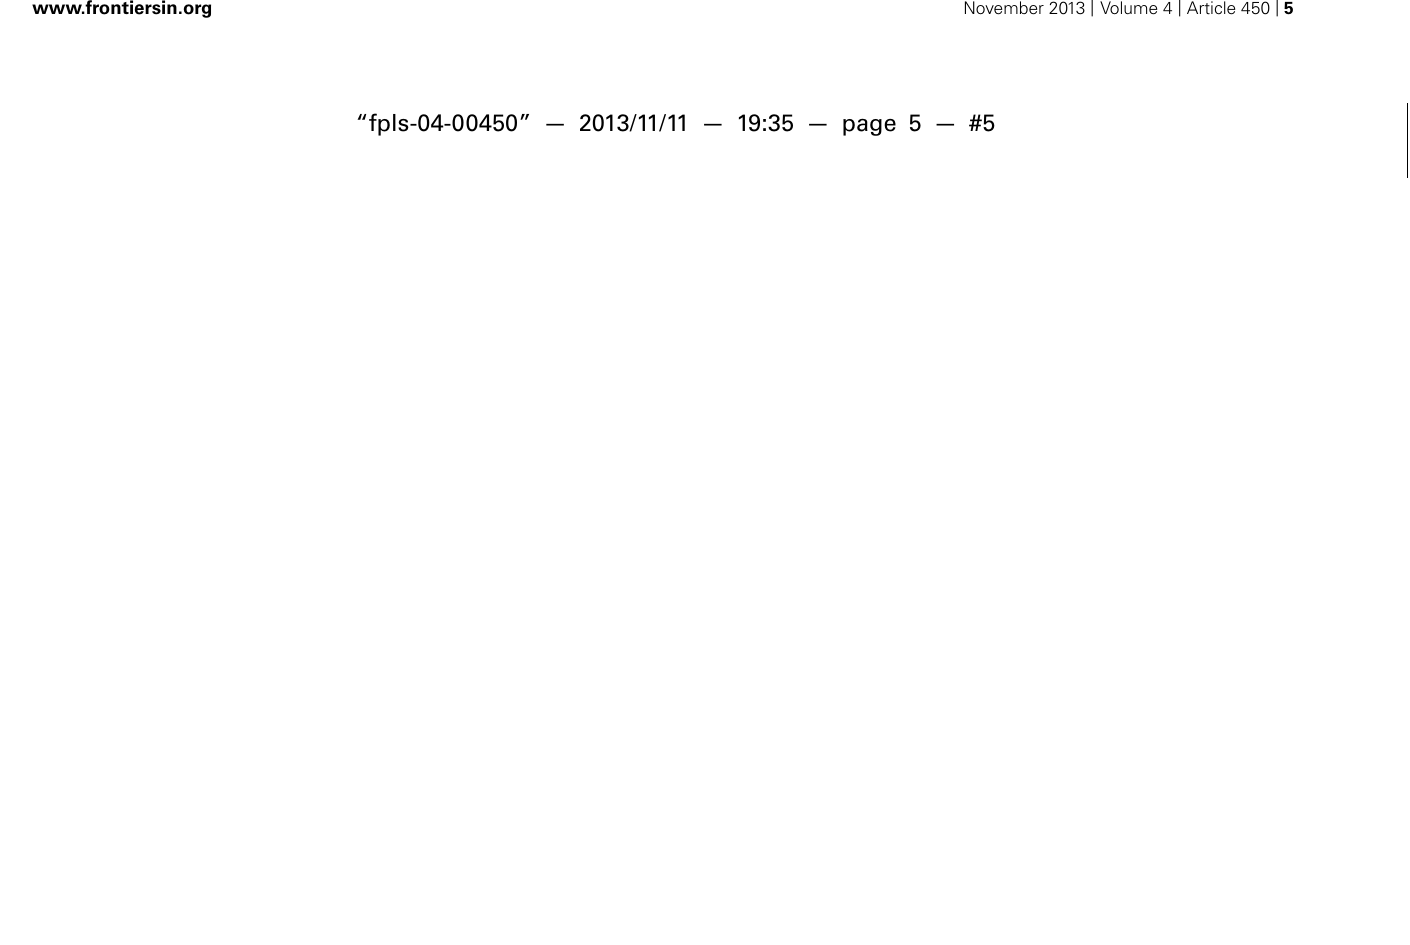
from different sources. Values of p K a , estimated with